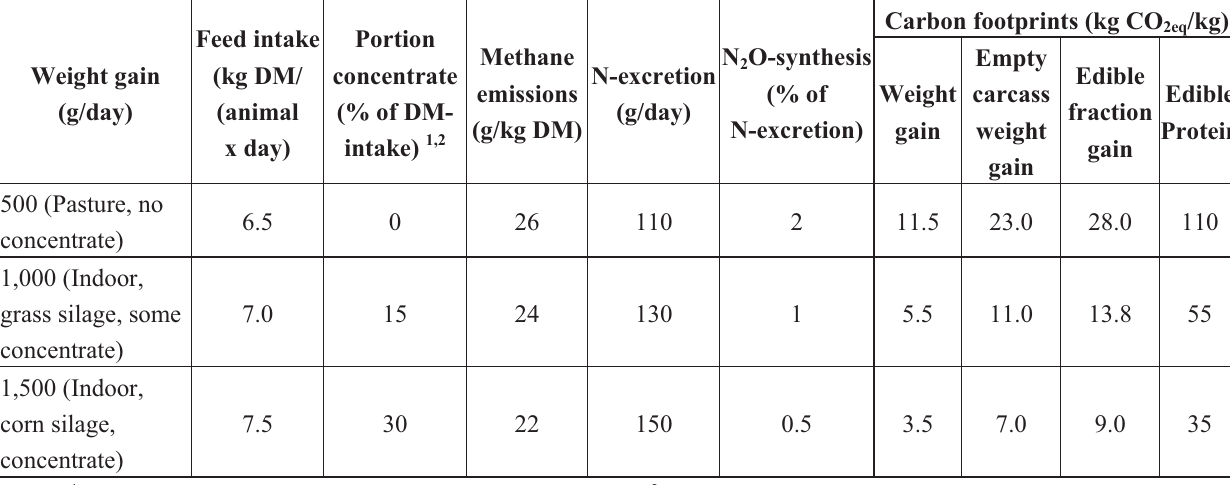
Table 5. Model calculations for CF of beef (150–550 kg body weight 1 ) depending on O-emissions and N-excretion feeding, weight gain, methane- and N 2